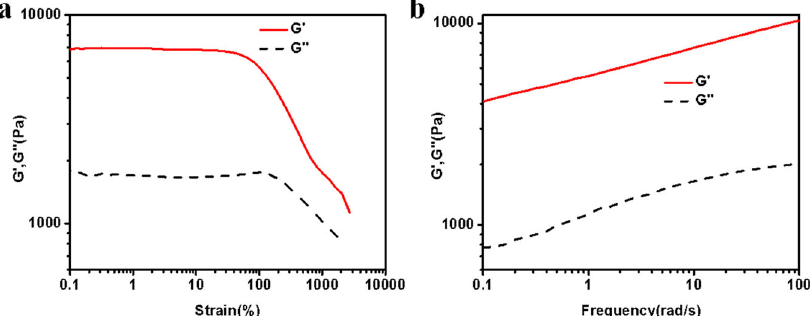
Fig. 3 Rheological characterization of the hydrogel. a G ′ (storage modulus) and G ” (loss modulus) as functions of strain. b G ′ and G ” as functions of frequency (ACA-PEG 20000 -ACA: Hy- α -CD =